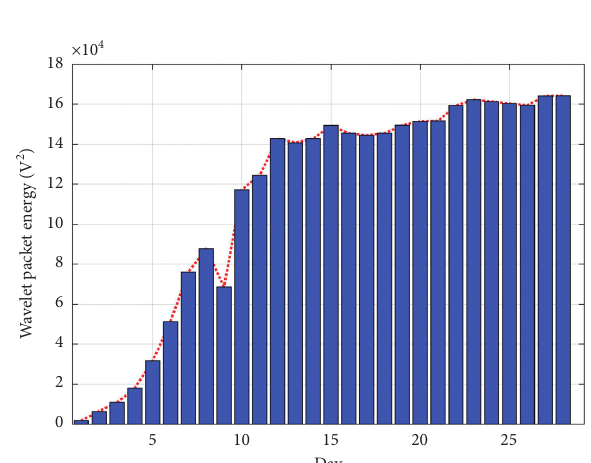
Figure 10: The result of wavelet packet